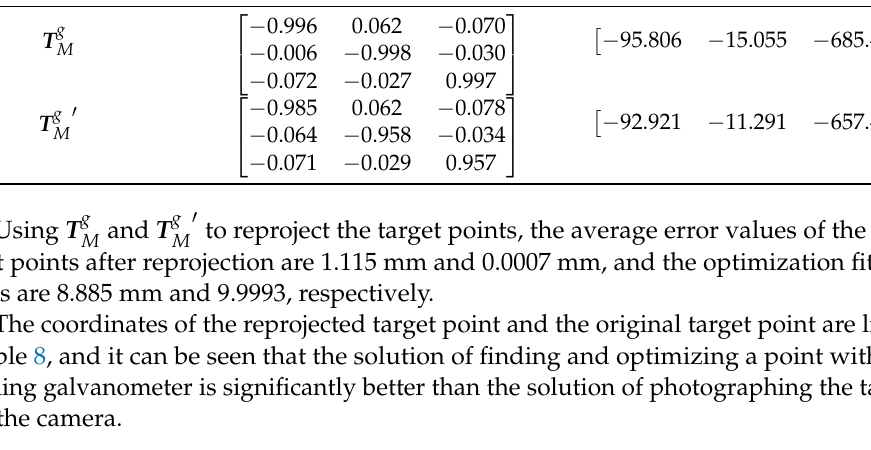
Table 8. Two calculation methods to obtain the reprojection point